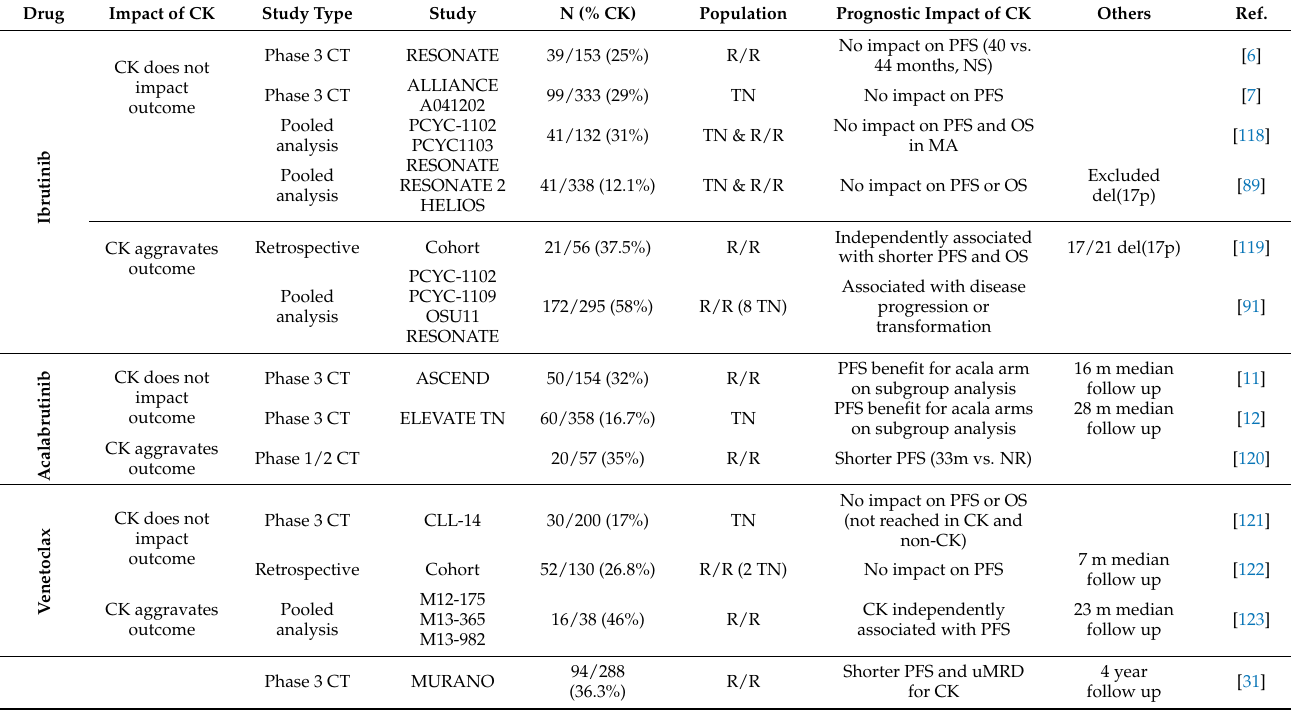
N = number of patients; CK = complex karyotype; REF = reference; CT = clinical trial; R/R = relapsed/refractory; PFS = progression free sur- vival; TN = treatment-naïve; OS = overall survival; MA = multivariate analysis; del(17p) = 17p deletion; m = months; uMRD = undetectable minimal residual disease; acala =